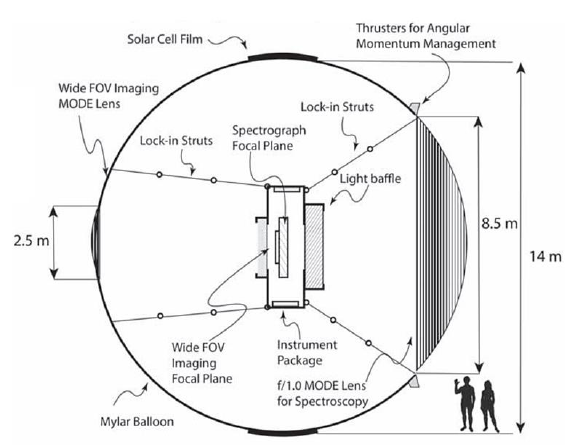
Fig. 3. Nautilus unit telescope concept using 8.5 m MODE